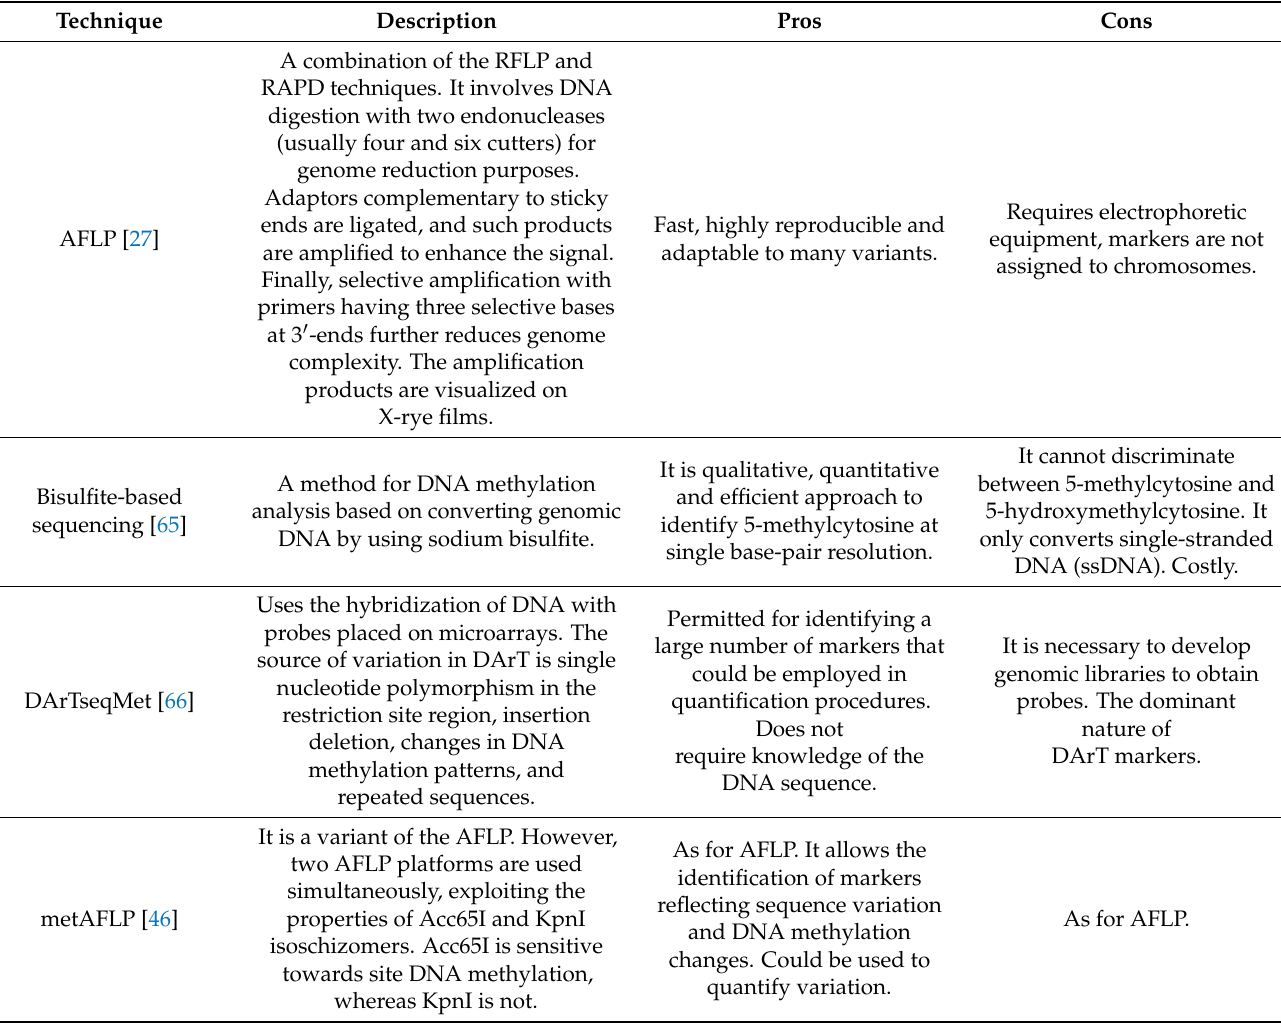
Table 1. The arrangement of molecular techniques used to study